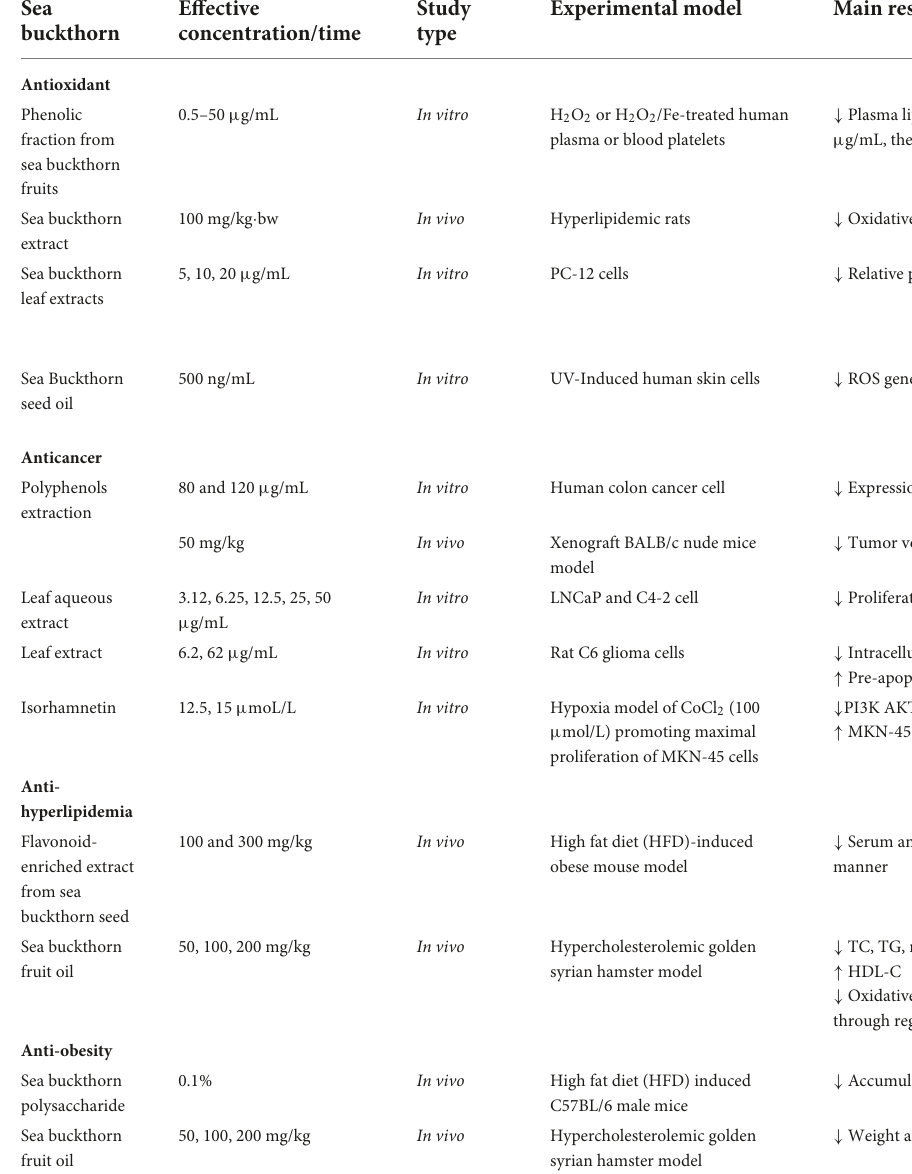
TABLE 4 Health benefits of sea